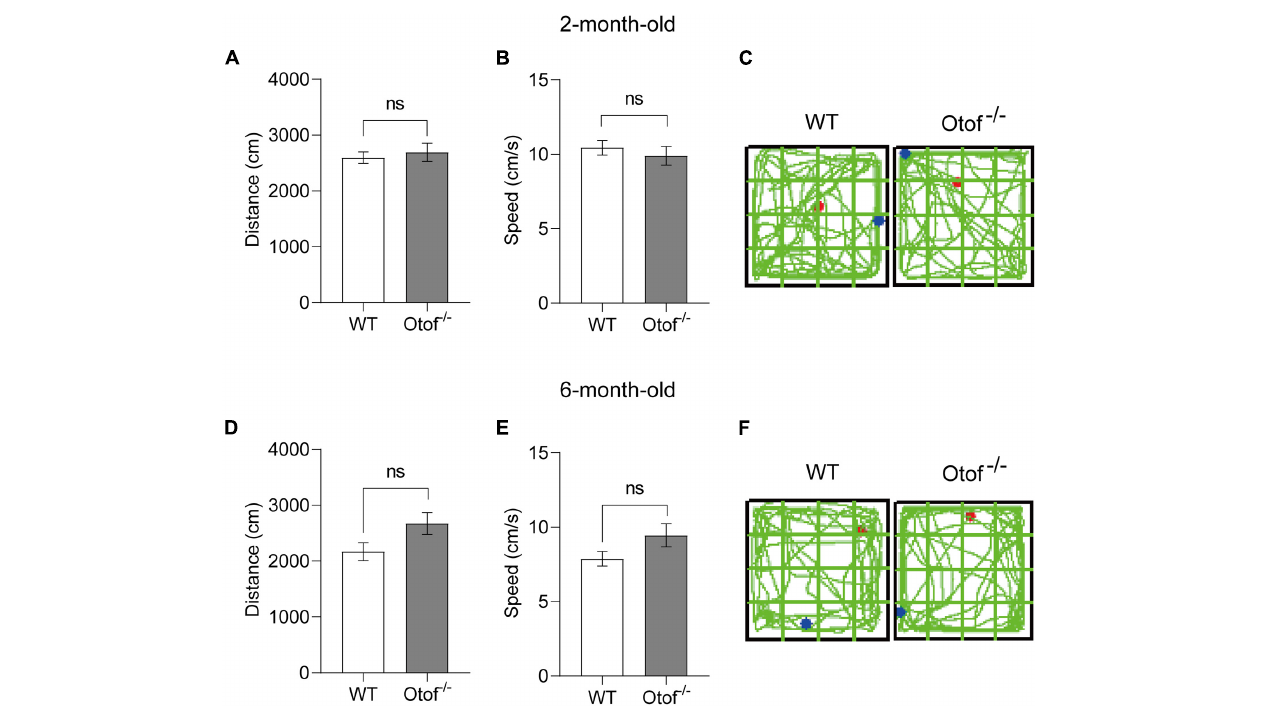
FIGURE 6 | Otof − / − mice showed normal motor ability in the open field ( L × W : 50 × 50 cm) at the ages of 2 and 6 months. (A,D) In the open field, there was no significant difference in the exploration distance (cm) between WT and Otof − / − mice group. (B,E) WT and Otof − / − mice showed no significant difference of speed (cm/s). (C,F) Representative exploration traces of WT mice and Otof − / − mice. The starting point and ending point of tracks in panels (C,F) were represented by a red dot and a green dot, respectively. All values are presented as mean ± SEM and analyzed by unpaired t -test for panels (A,B,D,E) . 2-month-old: WT, n = 15; Otof − / − , n = 17. 6-month-old: WT, n = 10; Otof − / − , n = 10. WT, wild-type mice; Otof − / − , otoferlin knockout mice; ns, not significant.